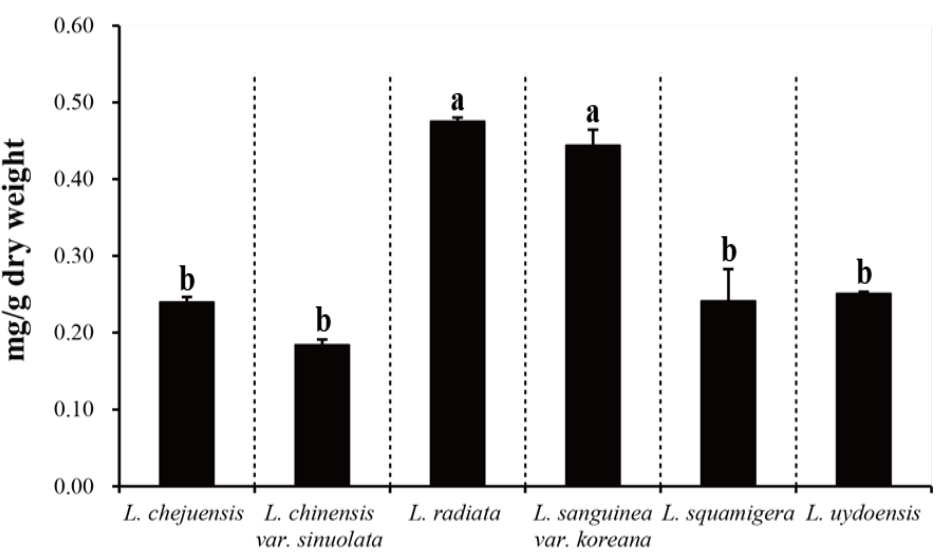
Figure 1. HPLC analysis of galantamine in six Lycoris spp. Mean values with different letters (a and b) were significantly different (p < 0.05, ANOVA,